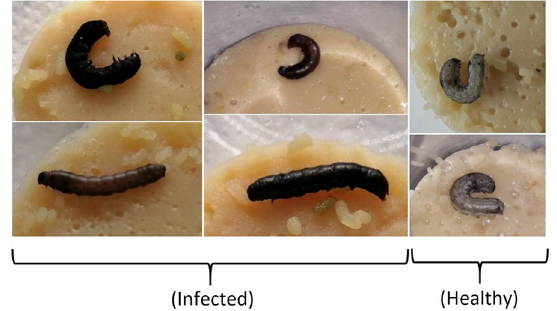
Fig. 4 Photographs showing differences between infected Spodoptera littoralis 4th instar larvae (to the left) and healthy larvae (to the right), upon transfection of the recombinant virus vSpli-phr DNA